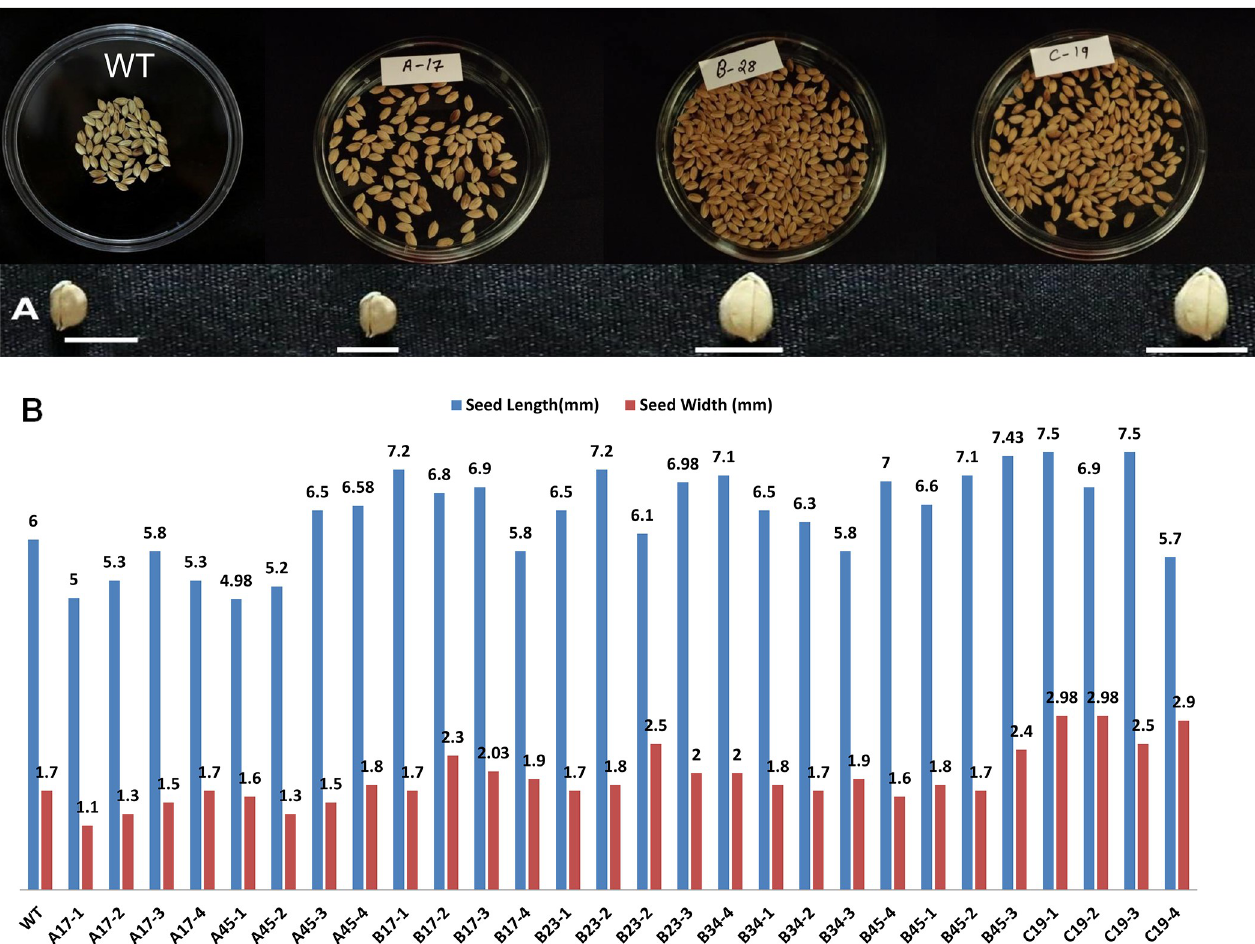
Fig 11. Morphological appearance and comparison of seed size of T2 transgenic progeny plants harboring gene constructs A , B and C and that of wild type (WT). Bar size is in mm. (A) morphological appearance of T2 seeds. Bar size depicting seed length for WT is 6.75mm, Construct A- 5.5mm, Construct B- 7.02mm and Construct C-7.5mm. (B) Seed length and width of WT and various lines derived from construct A, B and C are shown graphically.